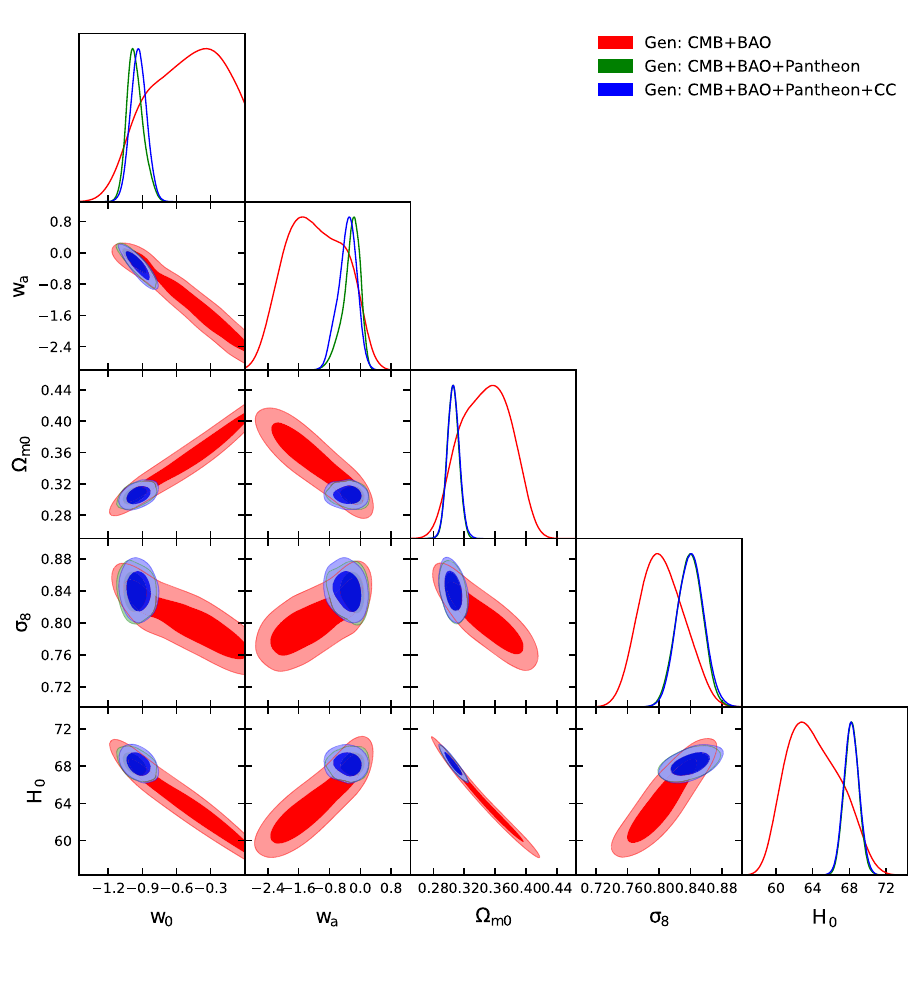
Fig. 6 68% and 95% CL contour plots for various combinations of the model parameters of the general parametrization of (6) (Gen) have been shown for different observational combinations. The figure also contains the one dimensional marginalized posterior distributions for the parameters shown in the two dimensional contour